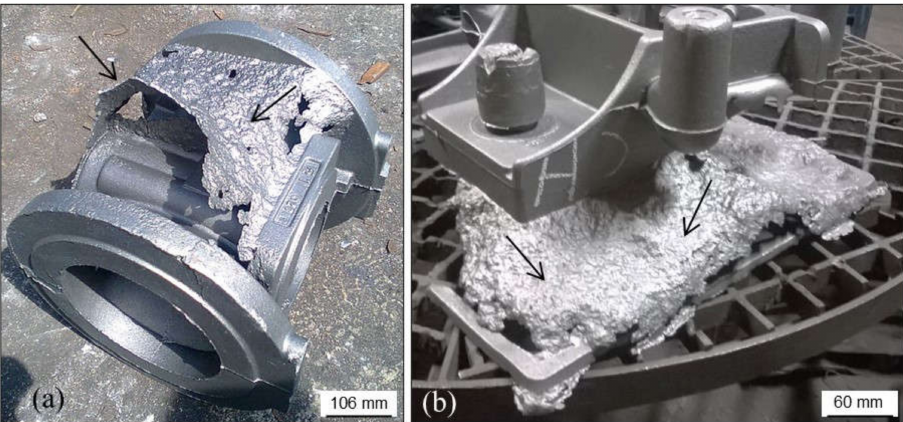
Figure 45. ( a ) Ductile iron casting with severe damages in the drag zone due to green sand mold breakdown. ( b ) Steel casting affected by green sand mold